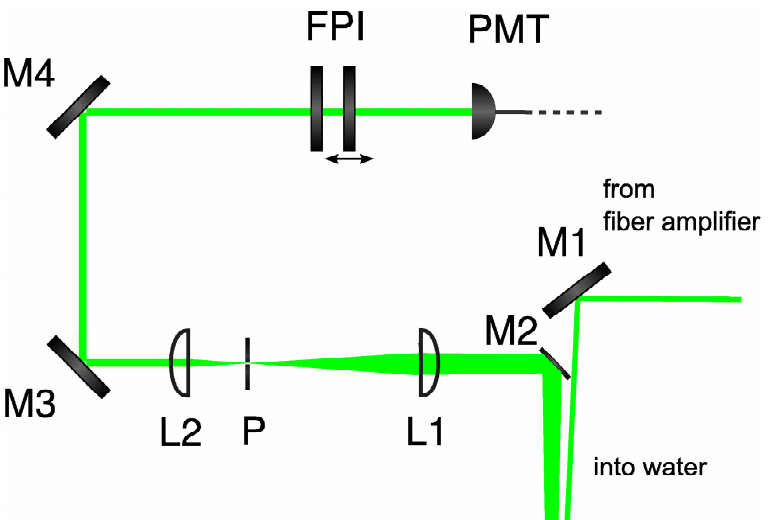
Figure 3 . The transmission and receiving optics are composed of mirrors (M), lenses (L), pinhole (P), scanning Fabry-Perot interferometer (FPI) and a photomultiplier tube